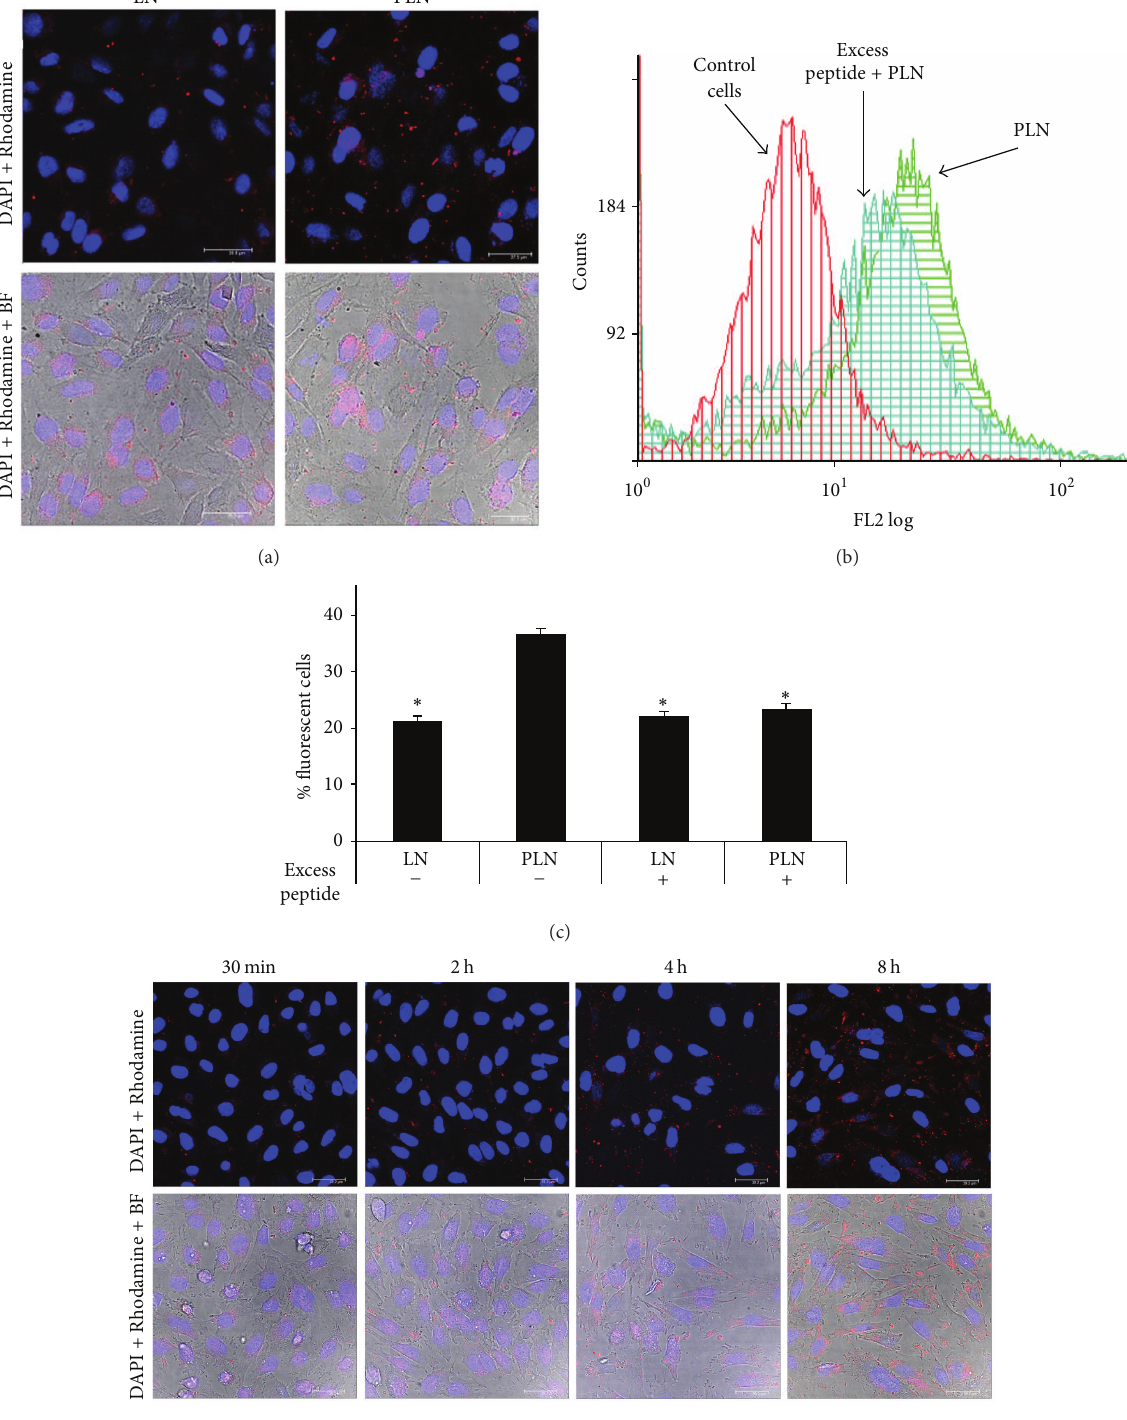
Figure 1: (a) Fluorescence and the overlay between fluorescence and phase contrast images showing the increase in the binding of fluorescently-labeled PLN (red) as compared with nontargeted LN on the surface of paraformaldehyde-fixed, TNF- 𝛼 activated EC. DAPI- stained nuclei appear in blue. Scale bar: 40 𝜇 m. (b) The flow cytometry graphs illustrate the reduced uptake of fluorescently labeled PLN by TNF- 𝛼 activated EC in the presence of excess of P-selectin binding peptide at 2 hours of incubation at 37 ∘ C. (c) Quantification of cellular uptake of fluorescently labeled LN and PLN in the absence or presence of excess peptide expressed as % of fluorescently labeled cells. Data represent the mean ± SD of three independent experiments, ∗ 𝑝 < 0.05 versus PLN in the absence of excess peptide. (d) Temporal visualization ofPLNinternalizationbyTNF- 𝛼 activatedEC(red),asrevealedbyconfocalmicroscopy.DAPI-stainednucleiappearinblue.Scalebar:40 𝜇